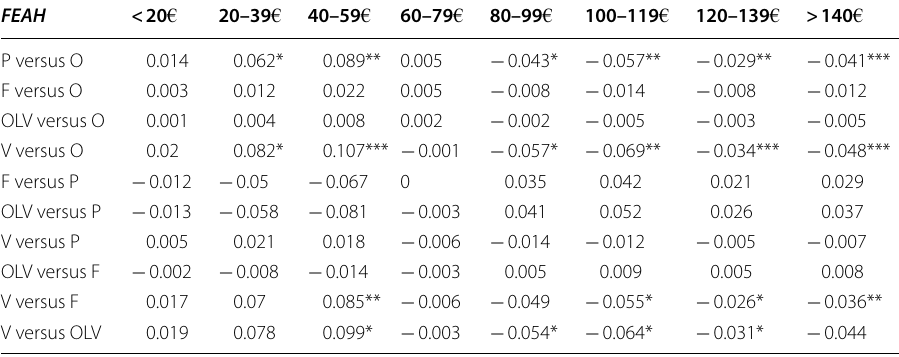
Statistical significance levels of 10, 5, and 1% are denoted as *, **, and ***, respectively Due to space constraints, the marginal effects of the covariates are available from the authors upon request